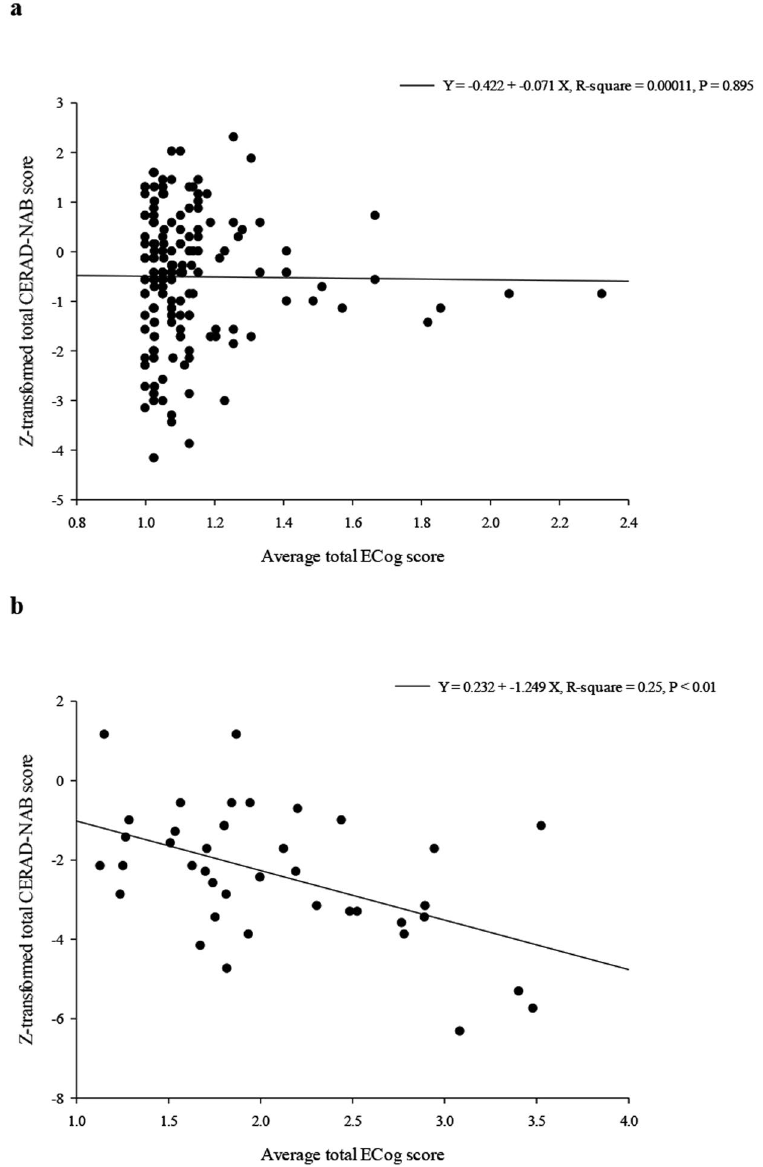
Figure 1. Scatter plot between average total ECog score and z-transformed CERAD-NAB score in ( a ) normally aging and ( b ) early stage of probable AD